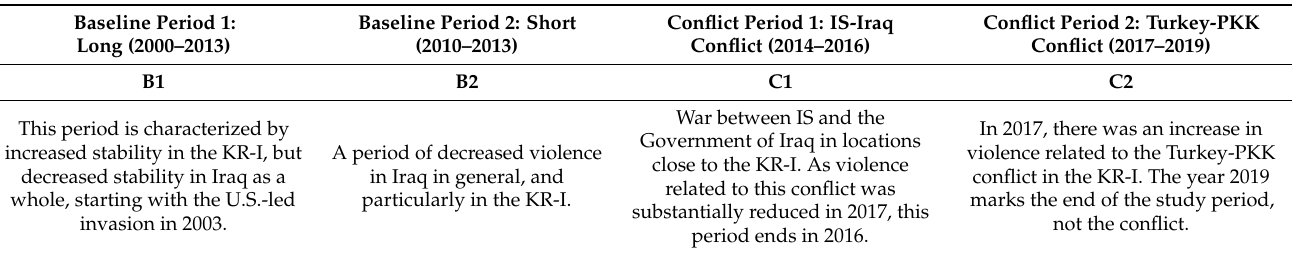
Table 1. Definition of the study periods based on data about the number of conflict-related deaths in Iraq and the KR-I from the Uppsala Conflict Data Program (UCDP) dataset. The study periods are split according to which conflict was dominant in the UCDP